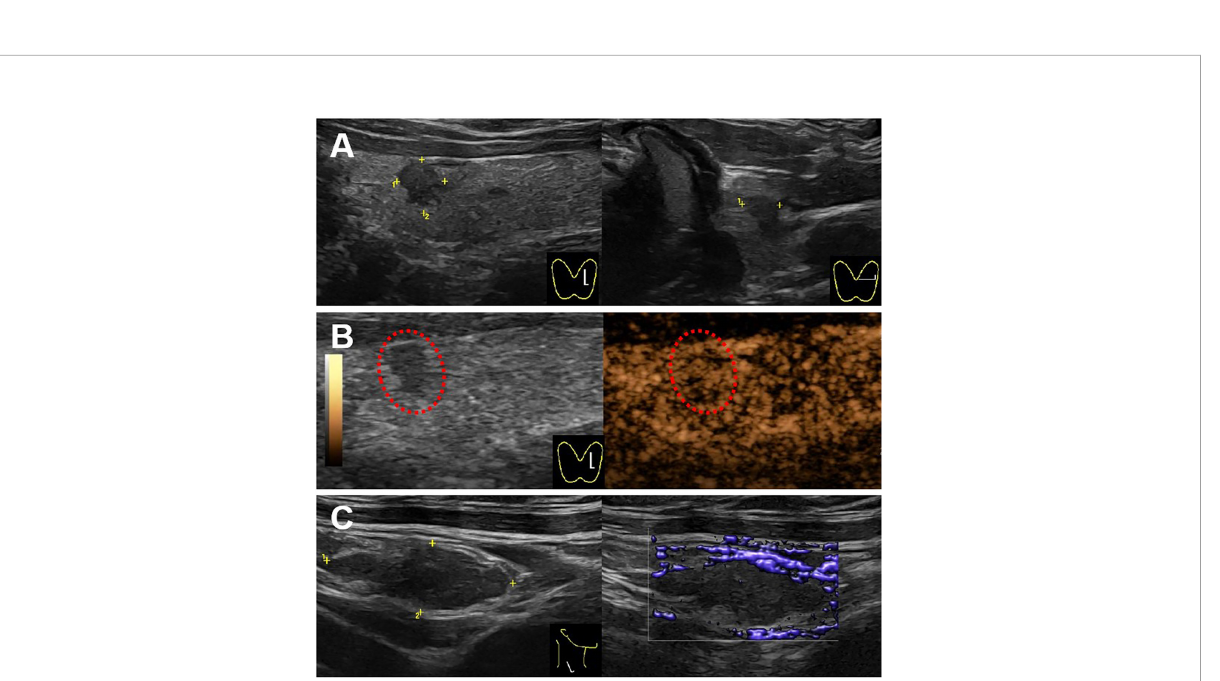
FIGURE 3 Ultrasound images for the thyroid and cervical lymph node. (A) A hypo-echoic solid nodule with an irregular margin and a taller-than-wide shape (4.7 × 3.7 × 5.3 mm) showed in the upper of left thyroid lobe on the gray-mode ultrasonography. (B) The nodule showed uneven iso- enhancement on the CEUS mode ultrasonography. (C) A swollen lymph node with the absence of fatty hilum (17.4 × 6.6 mm) showed in the right IV compartment of cervical lymph nodes, with no obvious blood fl ow in the lymph